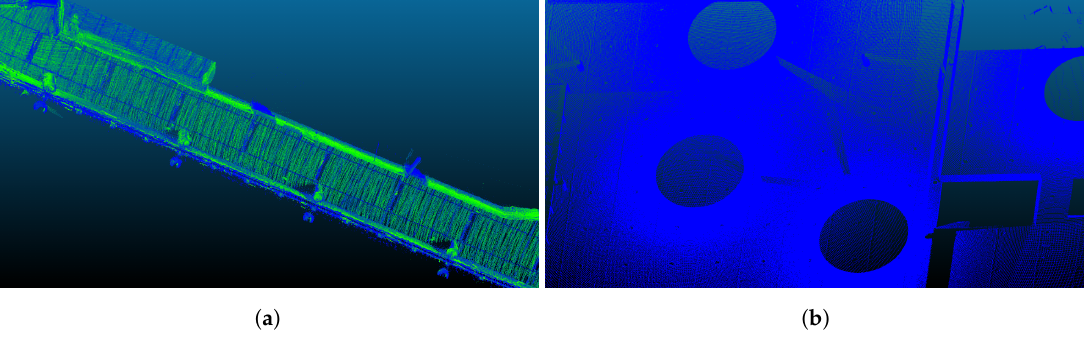
Figure 4. Point clouds for the two spaces used as ground truth for the experimental results: ( a ) classroom corridor, rectangular lamps (Model 4), extracted with the backpack system; and ( b ) hall, circular lamps (Model 5), extracted with FARO Focus3D X 330. Table 1. Technical characteristics of the two systems used to extract point clouds.